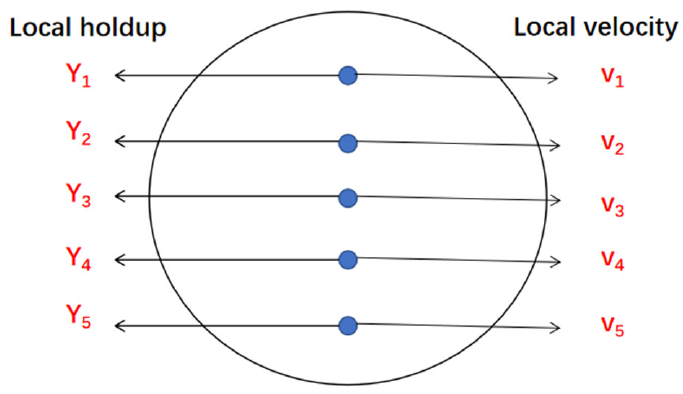
Figure 3. Diagram of measurement points.